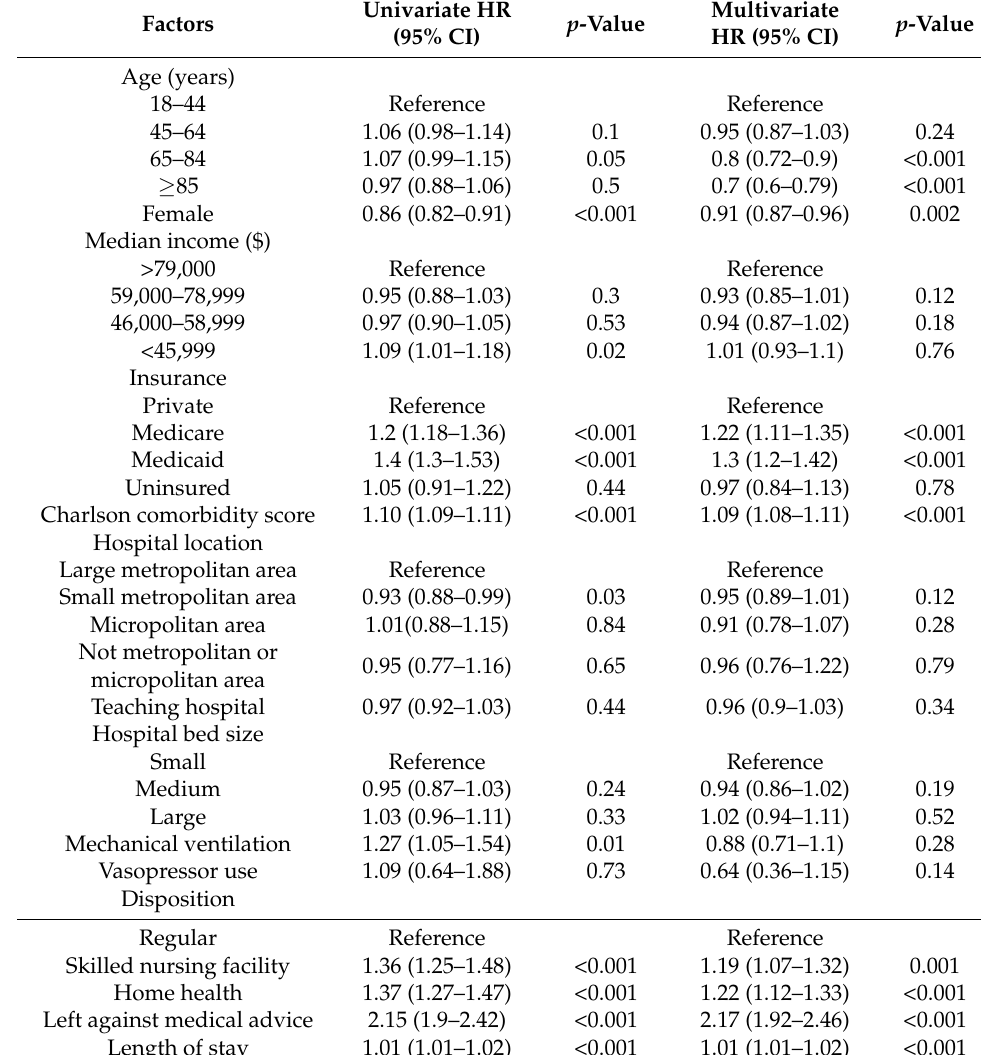
Table 4. Predictors for